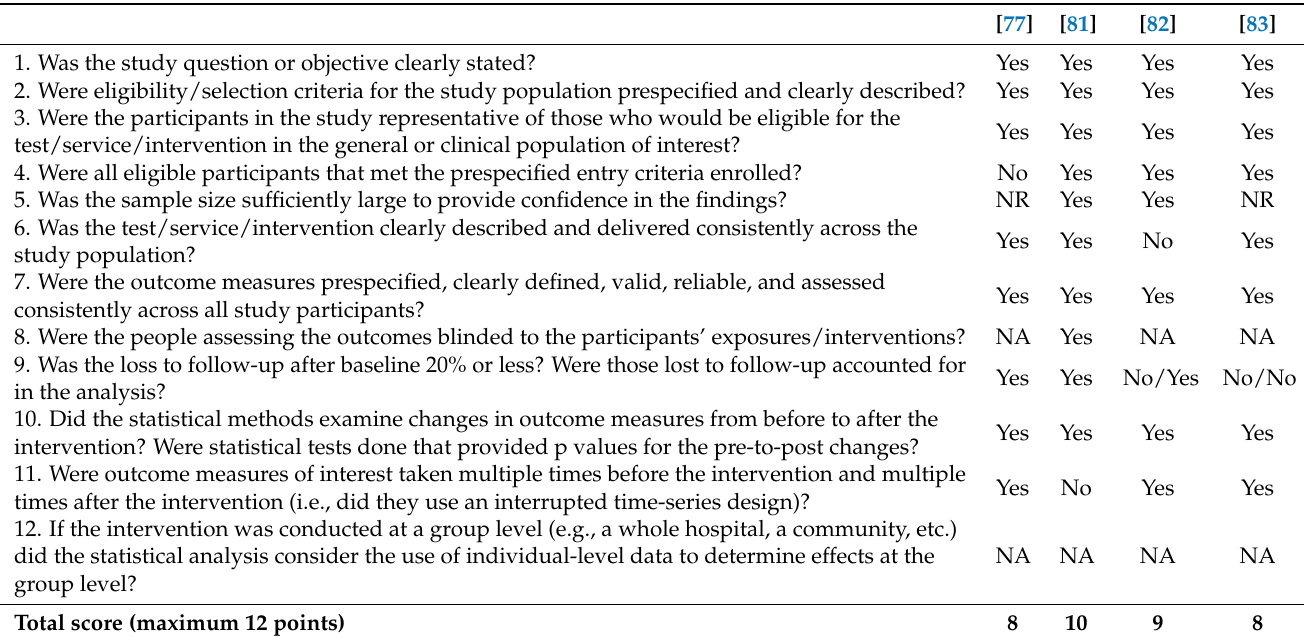
Table 3. Quality assessment of Before-After Studies.